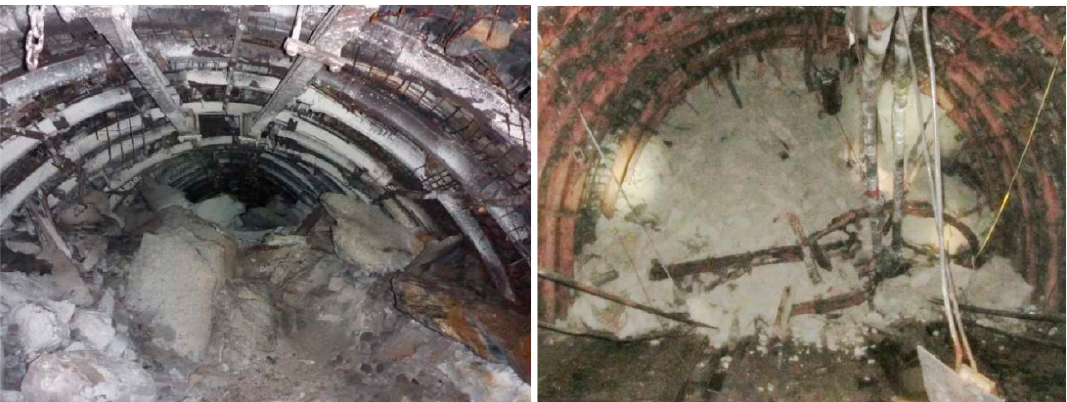
Figure 16. Rock collapses in Silesian hard coal mines.